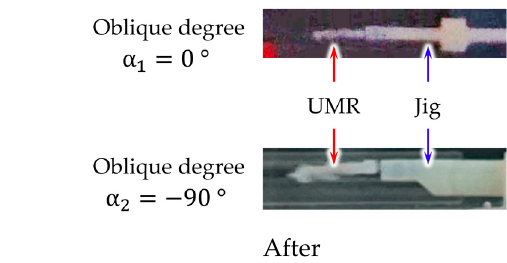
( a ) ( b ) Figure 13. ( a ) Success rate of recombination of the UMR with the delivery catheter without applying magnetic force; ( b ) with applying magnetic force. 3.2. In Vivo Experiment